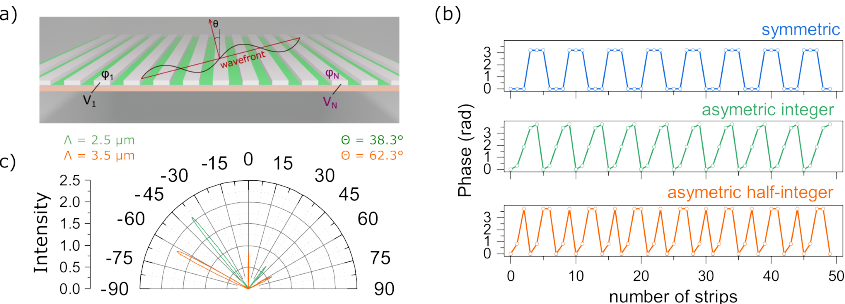
Figure 3. ( a ) Schematic representation of the structure for control over the angle of the first diffraction order; ( b ) three types of the phase distribution along the metagrating; ( c ) simulated far-field reflected intensity from the metagrating based on phase distribution presented in ( b ) in the case of asymmetric phase